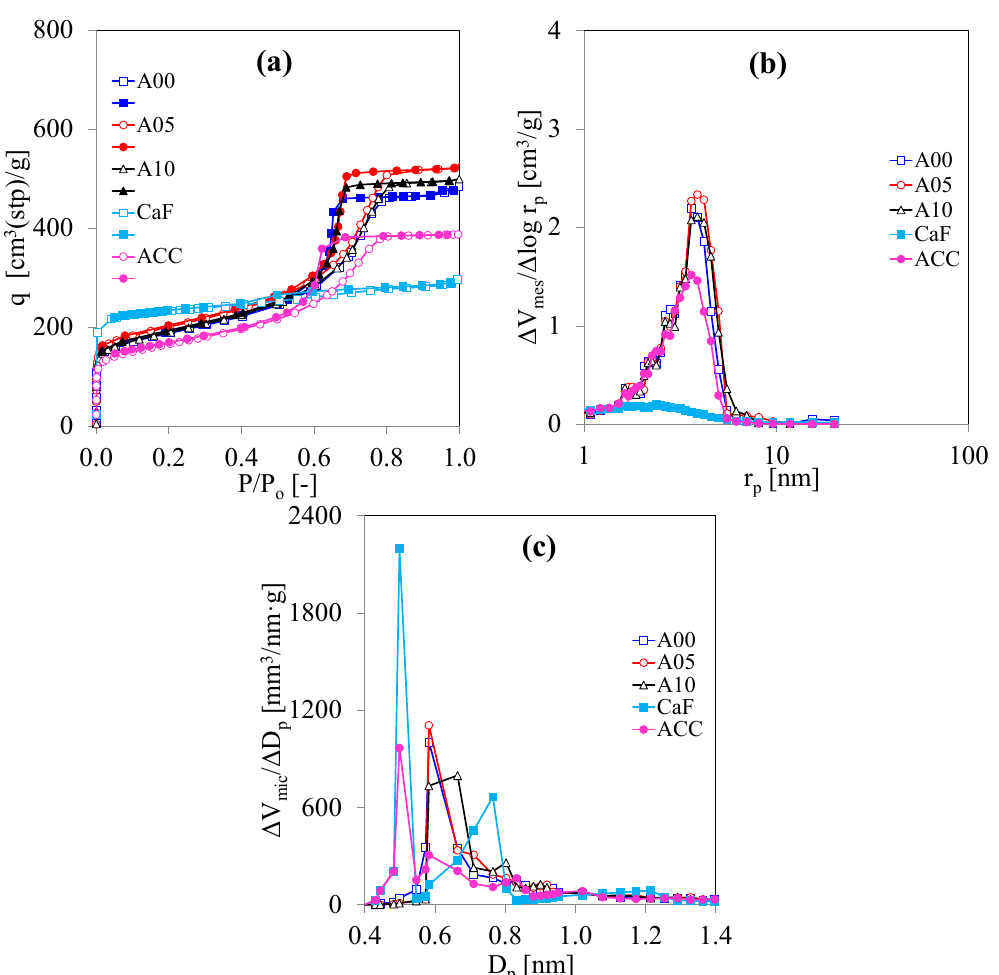
Figure 3. N 2 adsorption analysis of CaF and C/C composite xerogels prepared by using the CF/RF ratio for 0.00–0.10 g/g at R/C = 200 mol/mol and R/W = 0.5 g/cm 3 : ( a ) N 2 adsorption and desorption isotherms at − 196 °C (open symbols = adsorption; closed symbols = desorption), ( b ) mesopore size distribution, and ( c ) micropore size distribution.